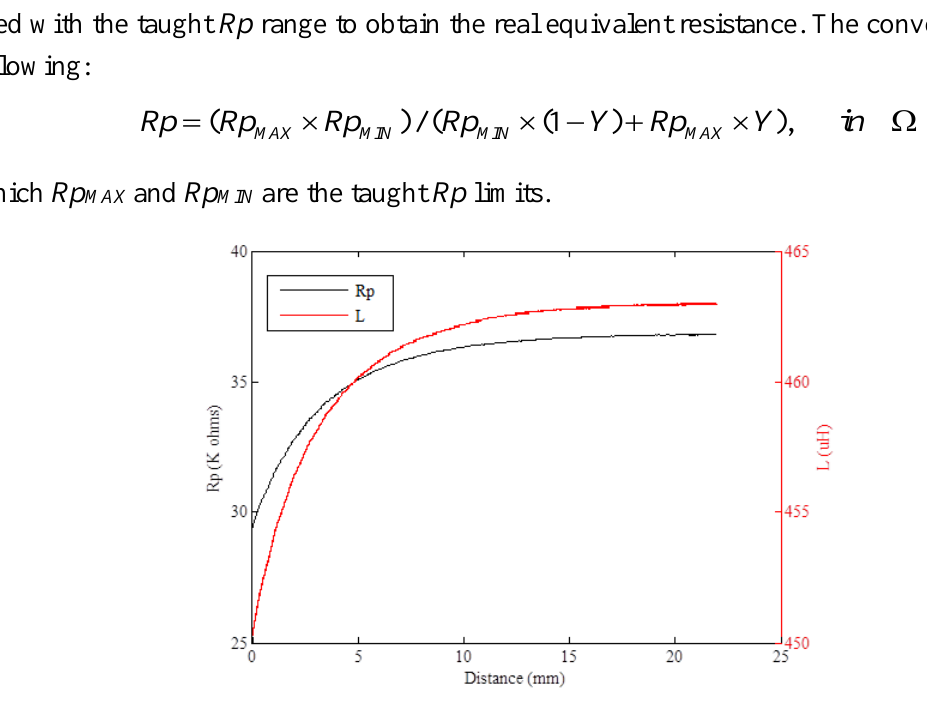
Figure 3. Rp and L results measuring a linear moving